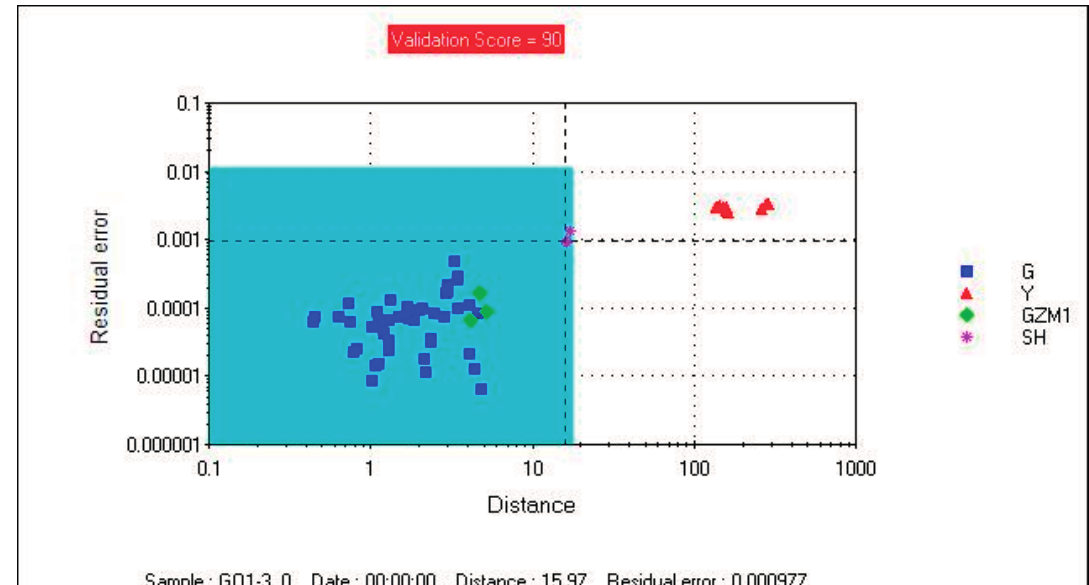
Figure 3. Sample GZM1 and sample SH projected onto the SIMCA model